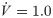
Increased transporter activity (k2 values) lead to increased aggressiveness and improved controller precision for transporter-based motif 1 zero-order controller (left panel) and motif 1 antithetic controller (right panel) during constant growth (see Figs 6 and 8).Phase 1: controllers are at their steady state, no growth, k2 = 1.0. Phase 2: constant growth (V˙=1.0) and k2 = 1.0. Both controllers show an offset in Ass below Asettheor. Phase 3: constant growth continues but k2 is increased to 1 × 103. Both controllers show improved precision and have their Ass close to Asettheor, but show different adaptation kinetics during the transition from phase 2 to phase 3. Rate parameters and initial concentrations, zero-order controller: k3 = 2.0, k4 = 20.0, k5 = 1 × 10−6, k6 = 10.0, k7 = 1 × 10−6, A0 = 2.0, E0 = 100.0, V0 = 25.0, M0 = 1 × 107. Rate parameters and initial concentrations, antithetic controller: k3 = 2.0, k4 = 10.0, k5 = 1 × 10−6, k6 = 10.0, k8 = 20.0, k9 = 1 × 10−6, A0 = 2.0, E1,0 = 1 × 10−2, E2,0 = 1 × 102, V0 = 25.0, M0 = O0 = 1 × 108.